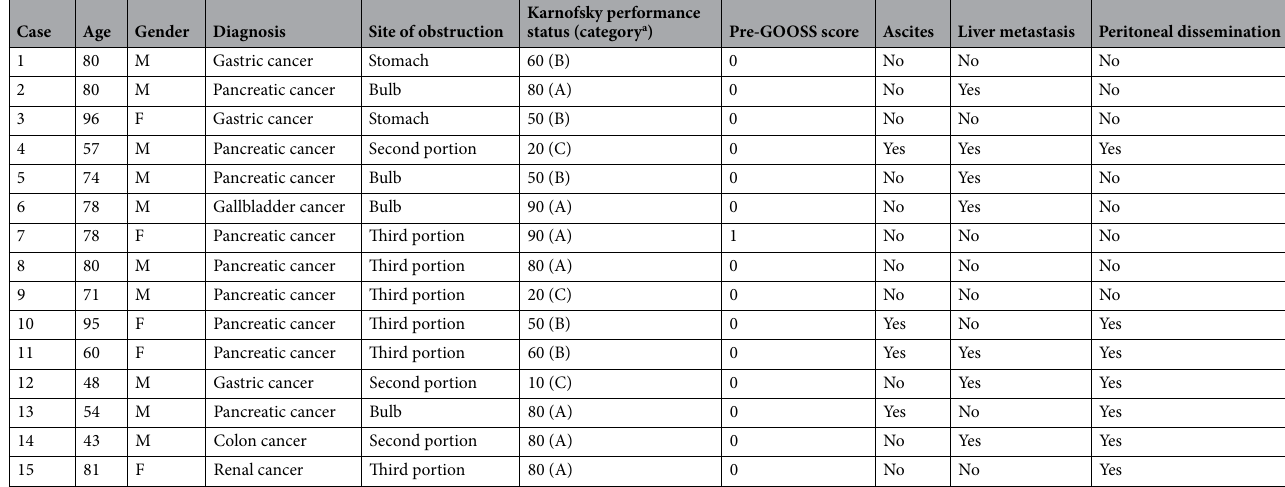
Table 1. Patient characteristics. GOOSS, gastric outlet obstruction scoring system. a According to the assessment by Karnofsky performance status, patients are divided into three groups: Group A (80–100) can independently perform daily activities, Group B (50–70) can perform daily activities with help, and Group C (0–40) requires continuous assistance and progressively approaches